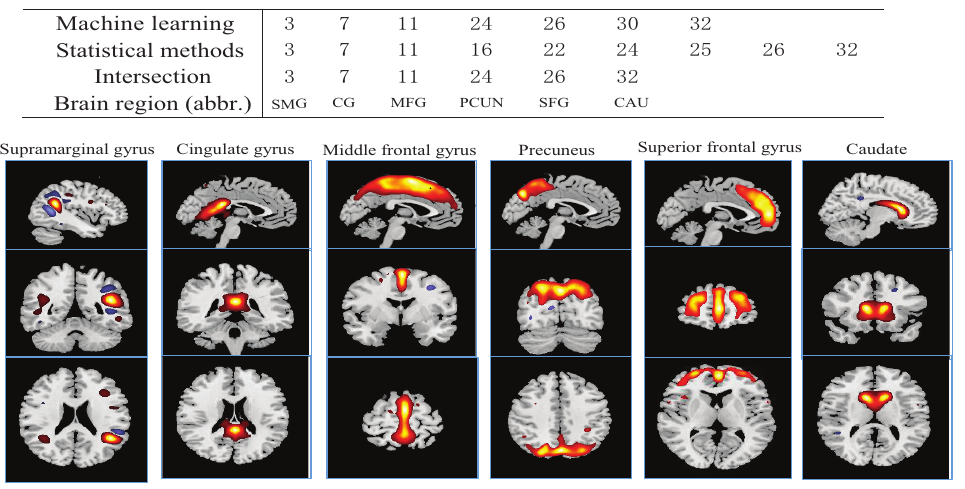
Figure 8. The selected abnormal brain regions of SZ by the hybrid method. Segall et al. presented the relationships between the cortical maps and the brain regions described by the SBM features [47].